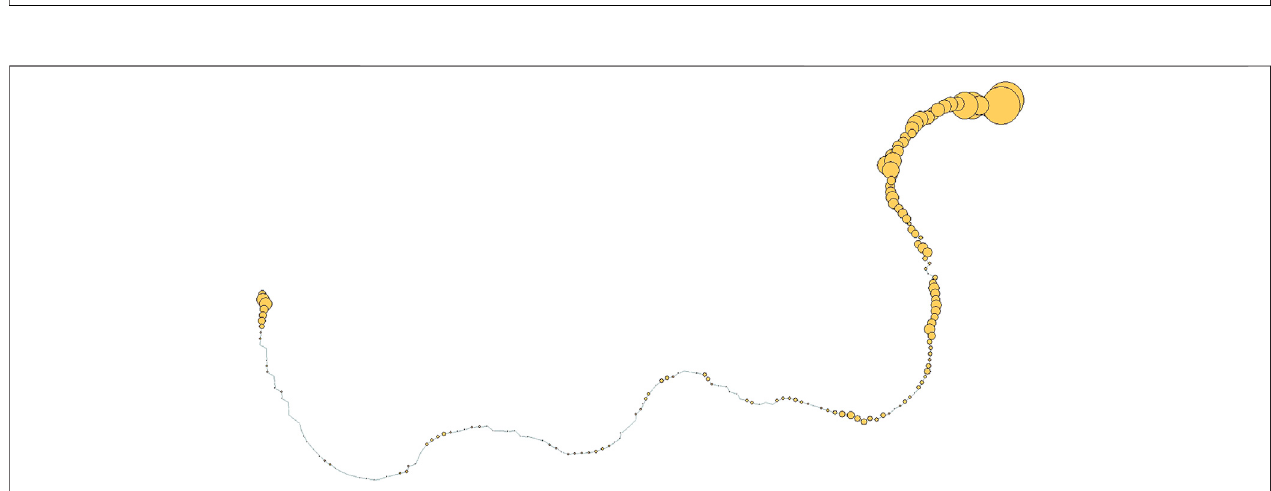
FIGURE3| FundamentalNetwork:Model2,200stocksin2009.Weighteddegreeishigherforthenodes(larger)neartheendpointsthanthoseinthemiddlesince no hierarchical structure is detected.